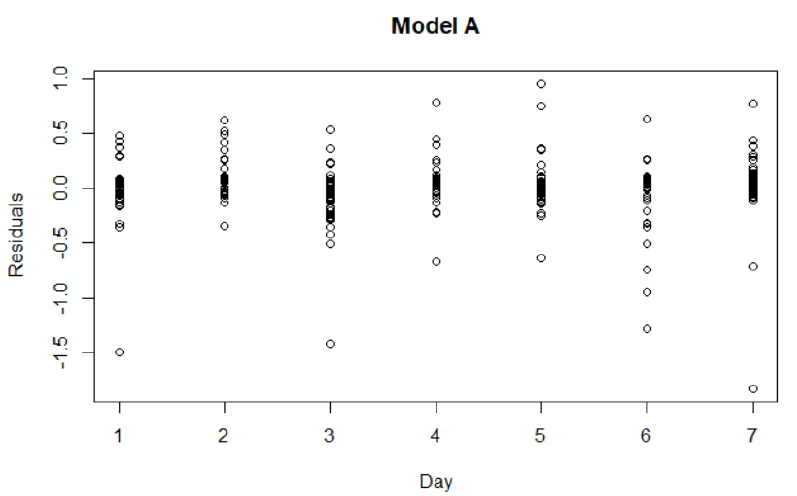
Figure A5. Residuals plotted by day.